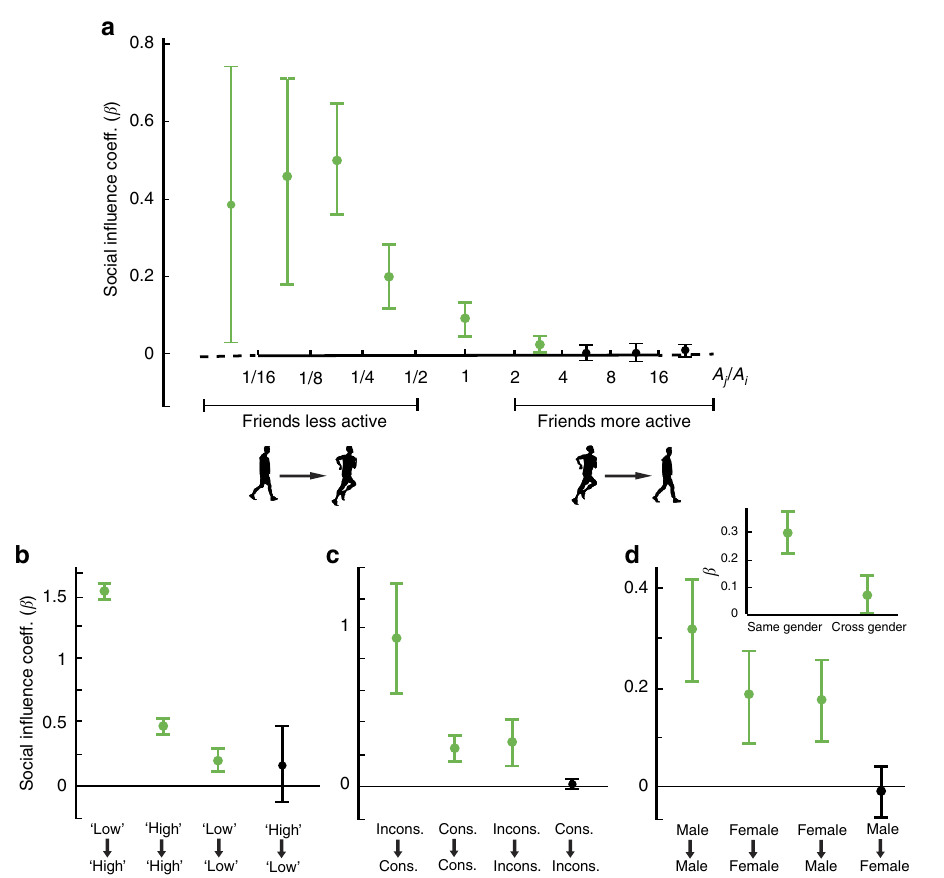
Figure 2 | Heterogeneity in social influence effects across relationships. The panels display social influence coefficients across dyadic relationships in which ego is ( a , b ) a more or less active runner than their friends, ( c ) a more or less consistent runner than their friends and ( d ) either the same or a different gender than their friends. Bars are 95% confidence